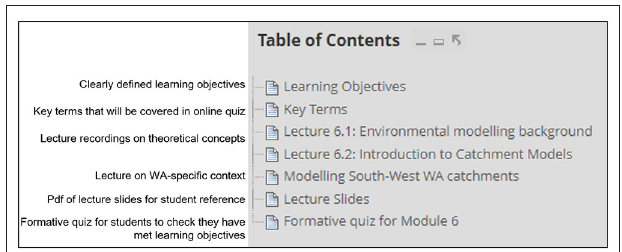
FIGURE 3 | Annotated Table of Contents from LMS showing modular delivery of learning content on the topic of Modeling Hydrologic Systems within the Water in a Changing Climate